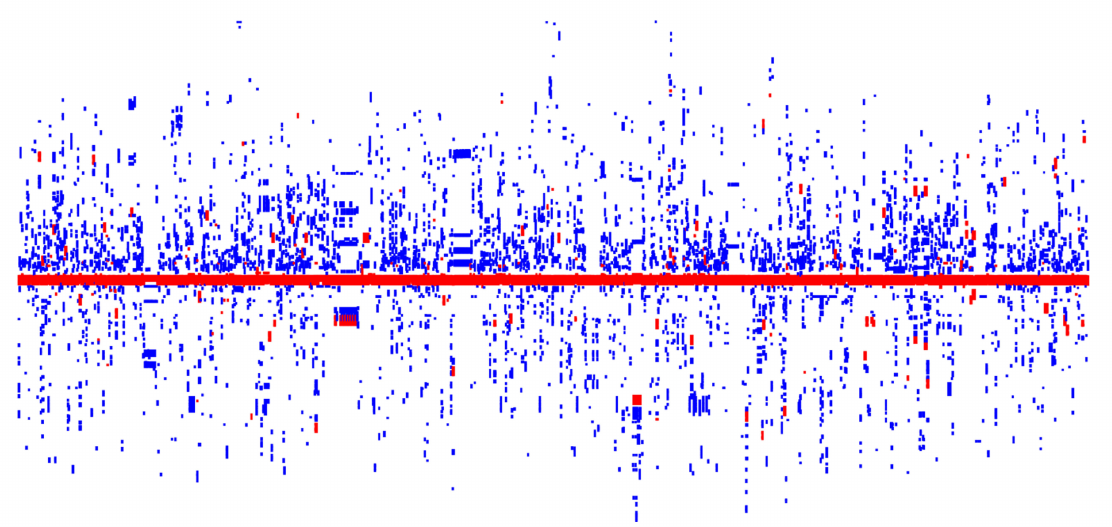
Figure 3. Visualization of the co-distribution of HRGs and ARGs in plasmids. Each plasmid is denoted by a vertical column, and the length of the HRGs (red), ARGs (blue), and all the other genes (white) represent the gene length. A maximum of 200 genes flanking the merA gene (in red) of each plasmid are visualized using Gcluster